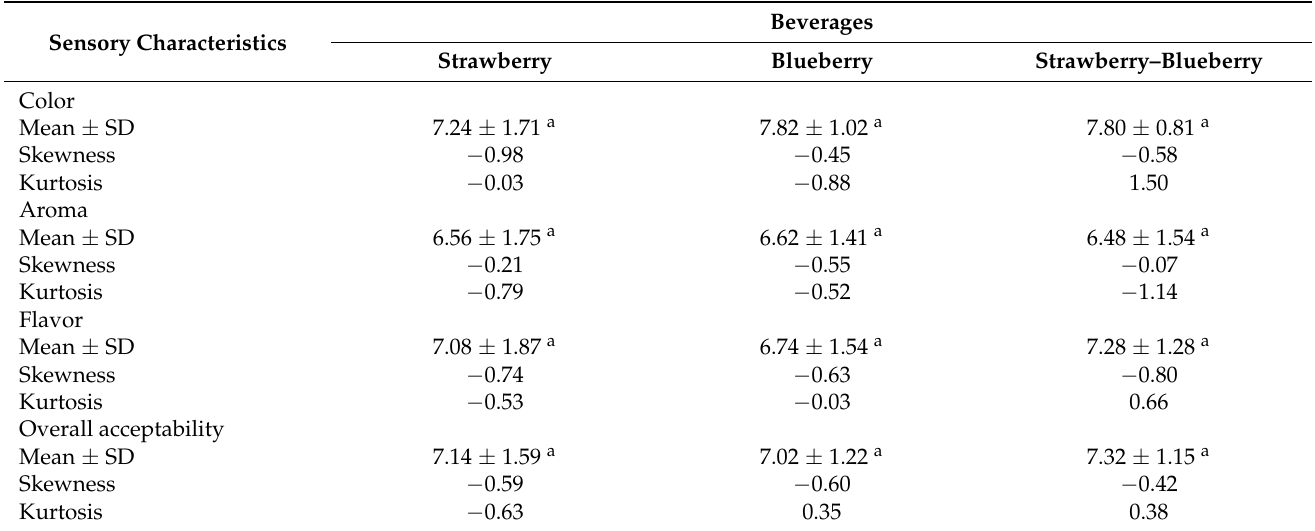
Table 2. Mean value, skewness, and kurtosis of the consumer acceptability test carried out with a 9-point hedonic scale of berry-based